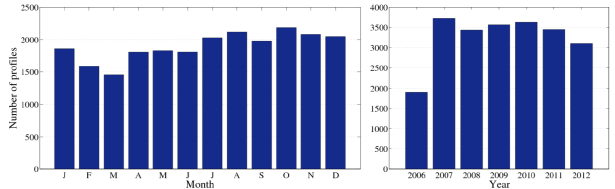
Figure 2. Total number of profiles obtained over OHP site during the period 1996-2007 from 2 Fig. 2. Total number of profiles obtained over OHP site during the the ground-based lidar for each month (on the left) and year (on the right). 3 period 1996–2007 from the ground-based lidar for each month (on the left) and year (on the right).